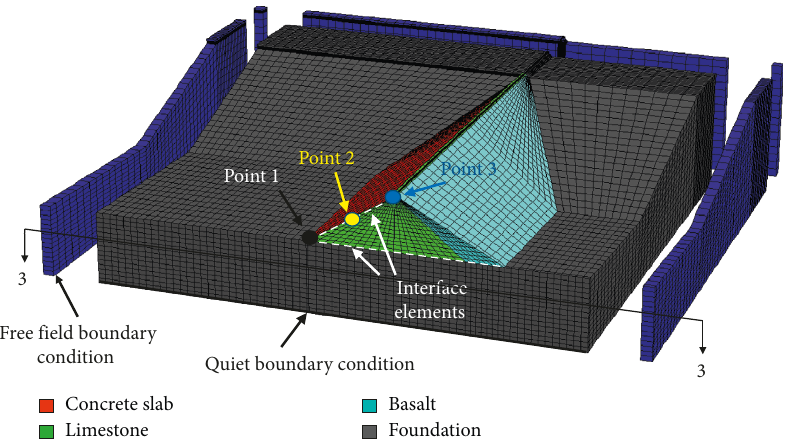
Figure 14: Numerical analysis algorithm for nonlinear seismic analyses.